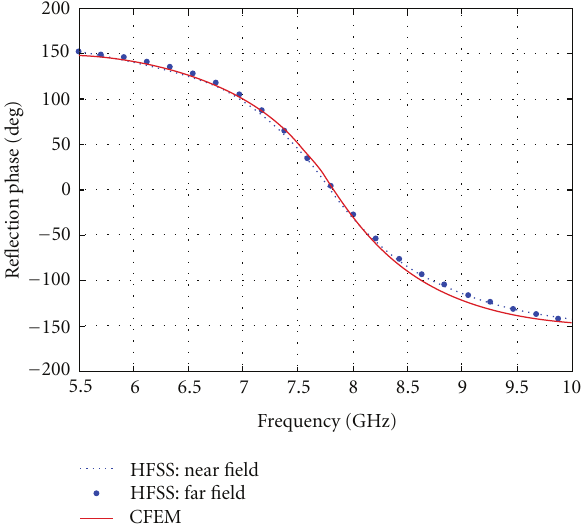
Figure 9: The reflection phase of the square patch AMC in Figure 6, for TE oblique incidence at θ = 150 ◦ , φ = 90 ◦ is shown and compared with the results obtained using HFSS (near-field and far- field methods).